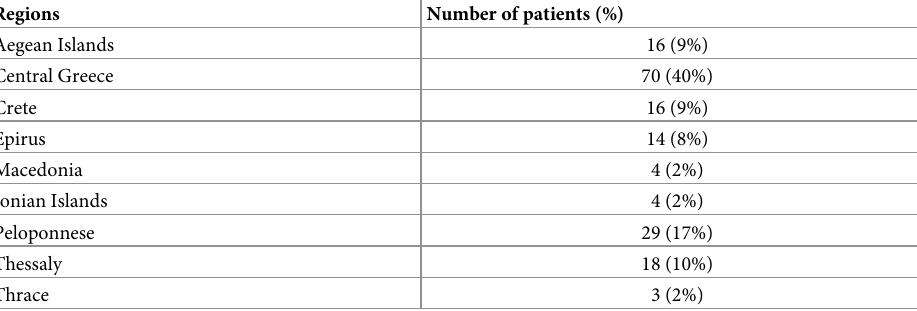
Table 3. Murine typhus patients among the nine greek regions.